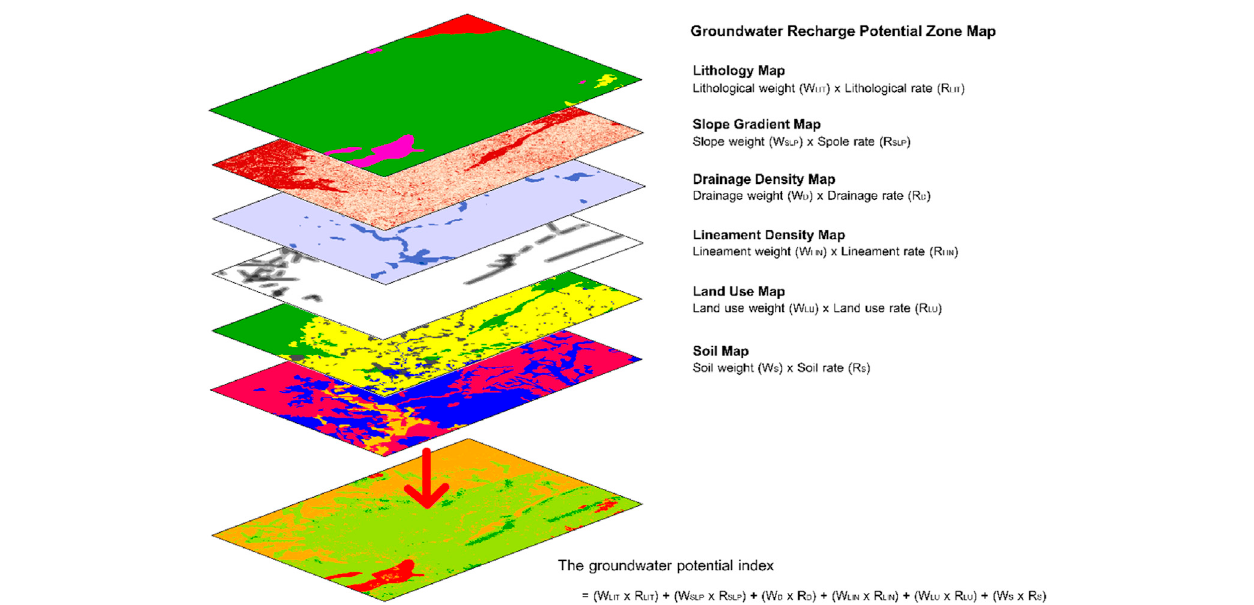
FIGURE 4 | Process of GRP zone analysis by using the GIS technique.